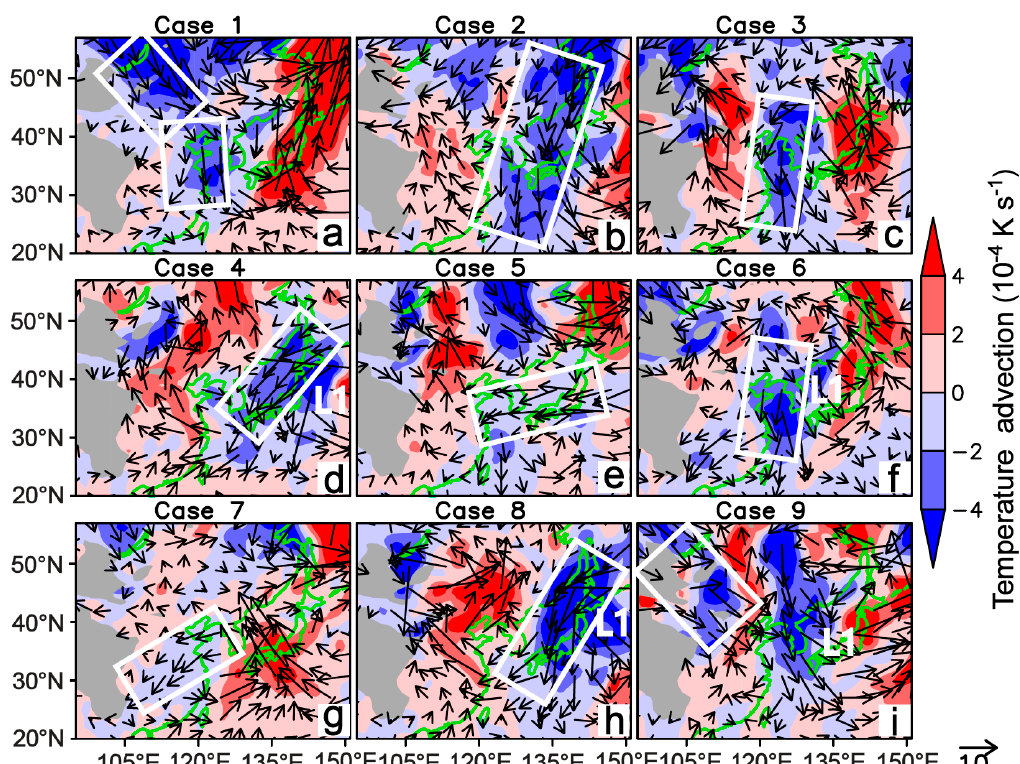
Figure 9. Same as Figure 8, except for temperature advection (color-shaded; units: 10 − 4 K s − 1 ) caused by the synoptic-scale transient anomaly of wind vector (units: m s − 1 ) for cases 1-9 (a-i). The rectangles indicate the temperature advection areas associated with the formation of SSTA-GH ‘H’ shown in Figure 8.